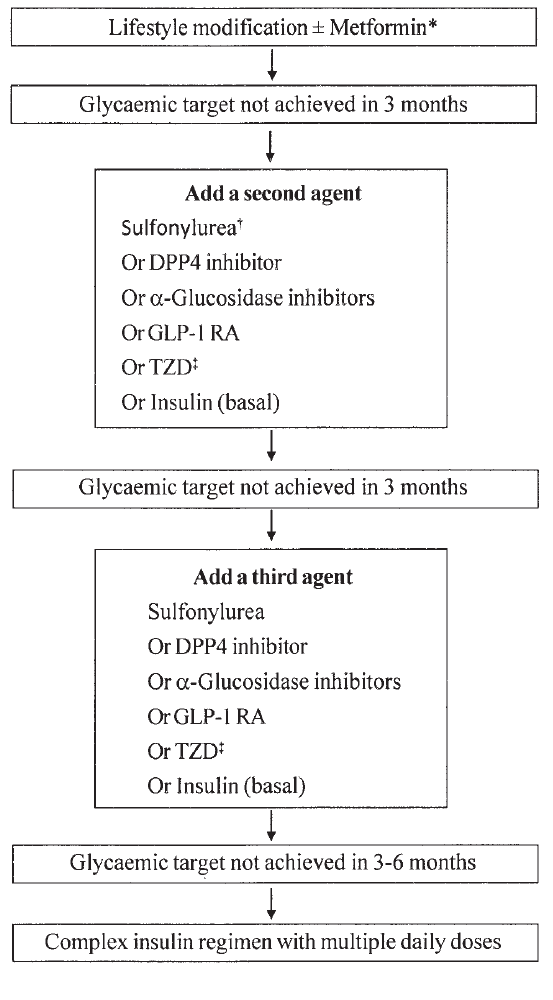
Figure 1. Algorithm for glucose lowering in type 2